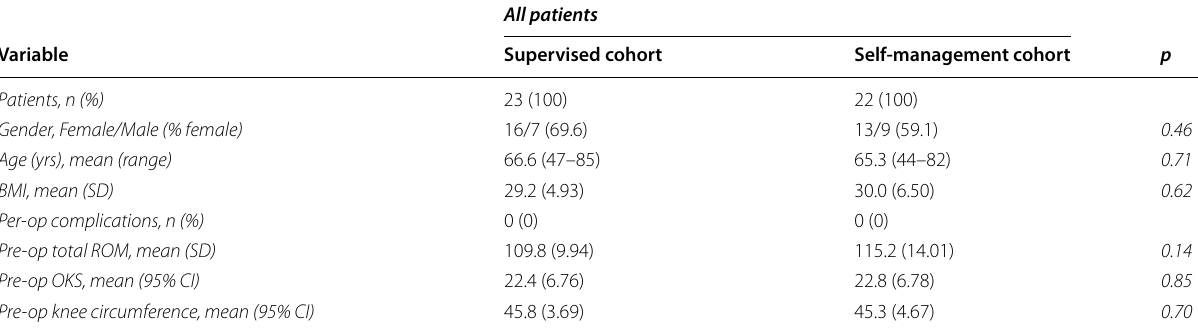
Table 1 Baseline